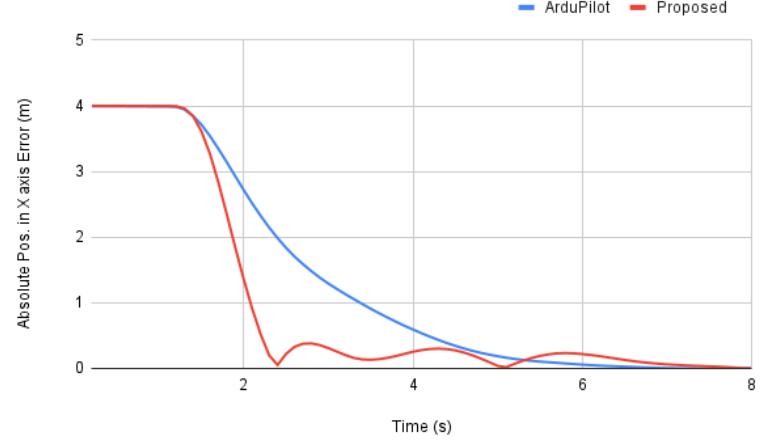
Figure 9. Absolute Error comparison between ArduPilot and the proposed